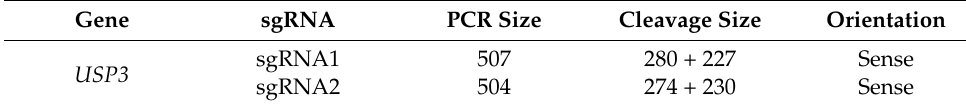
Table 2. PCR amplicon and T7E1 cleavage